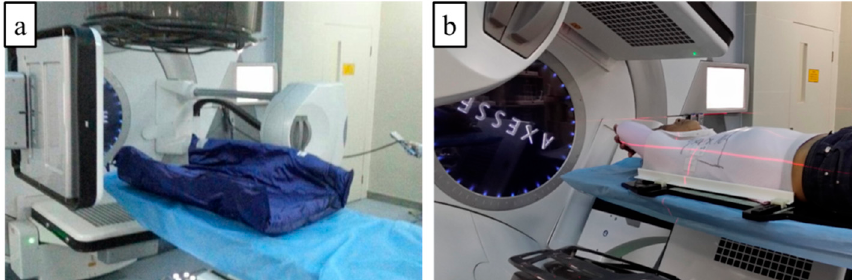
Figure 3. Fixation of chest tumor radiotherapy ( a ) Vacuum pad fixation, ( b ) Thermoplastic membrane fixation).